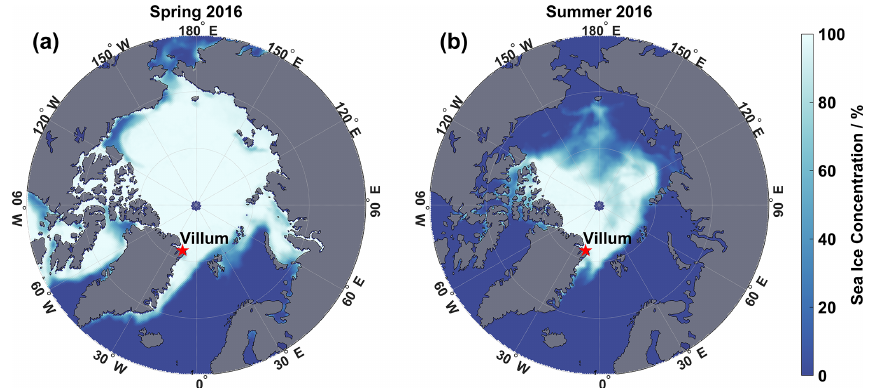
Figure 1. Location of Villum Research Station at Station Nord. Villum is shown with a red star. Average sea ice concentration is included for the spring campaign (a) and summer campaign (b) . Sea ice concentrations were taken from the National Sea&Ice Data Center (https: //nsidc.org/home, last access: 21 October